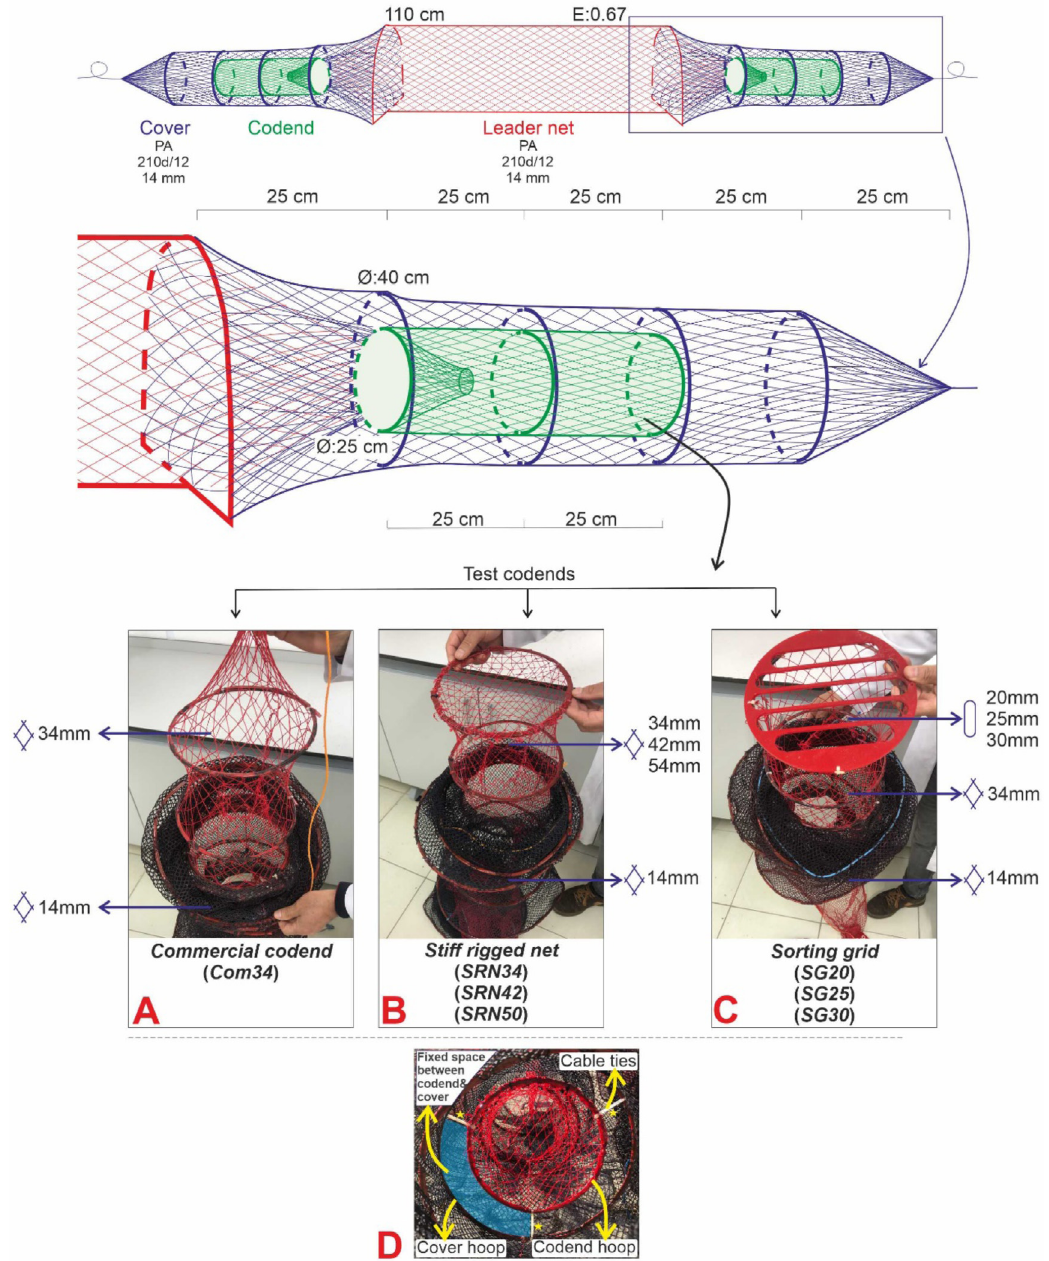
Fig. 1. Technical properties of experimental fyke nets and test codends used in the study A. Commercial codend ( Com34 ). B. Stiff rigged net ( SRN34, SRN42, SRN54 ). C. Sorting grid ( SG20, SG25, SG30 ). D. The process of preventing masking